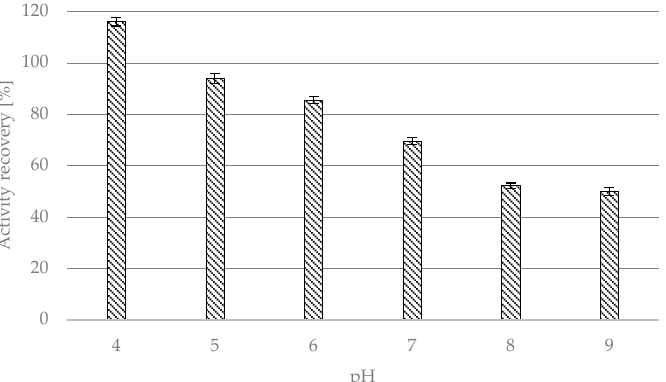
Figure 1. Effect of buffer pH on CALB activity recovery. Reaction conditions: CALB immobilized onto Octyl-Sepharose CL-4B (50.0 mg), or free lipase (10.0 mg), phosphate buffer (100 mM, pH 7.4), the emulsion of gum Arabic and olive oil, temperature 37 °C, incubation 30 min. Data are presented as means ± standard deviations of three analyses ( n = 3). The error bars represent the standard de- viations of the mean.